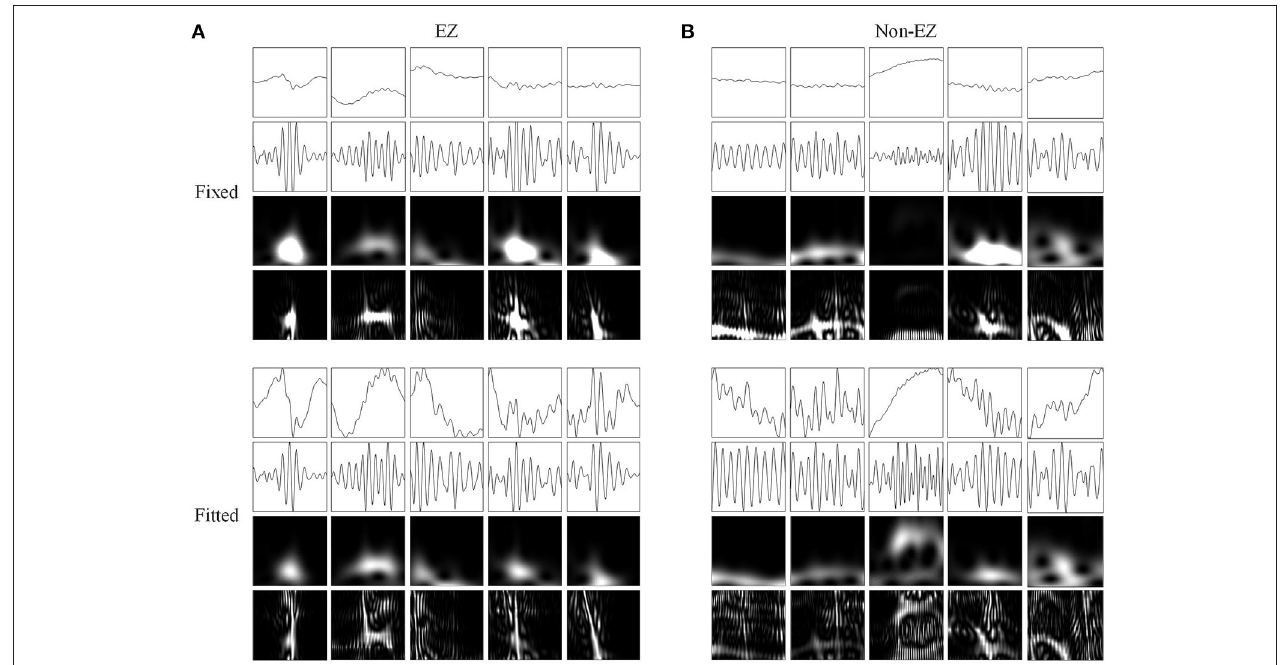
FIGURE 5 | Network inputs in the form of two-dimensional pictures of ripples. (A) Two-dimensional pictures (96 × 96 × 1 pixel) of five ripples in different channels of EZs. Upper and lower four panels are fixed and fitted scales. The four panels are original waveforms, filtered (80–200Hz) waveforms, wavelet spectrum images, and SPWVD spectrum images. (B) Two-dimensional pictures (96 × 96 × 1 pixel) of ripples in different channels of non-EZs. Upper and lower four panels are fixed and fitted scales. The four panels are original waveforms, filtered (80–200Hz) waveforms, wavelet spectrum images, and SPWVD spectrum